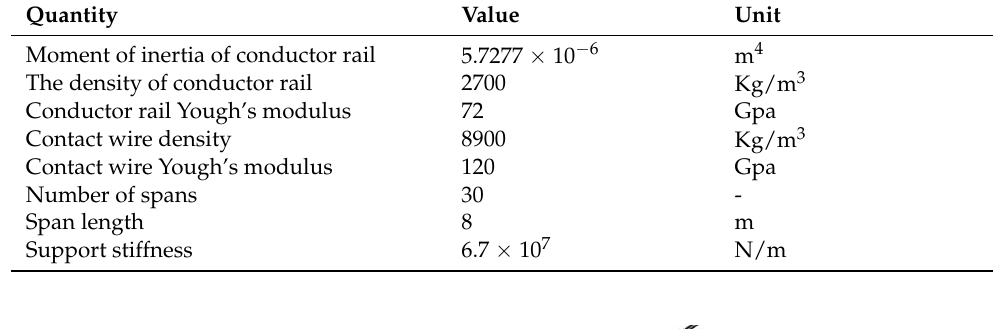
Table 4. Key parameters of rigid catenary.